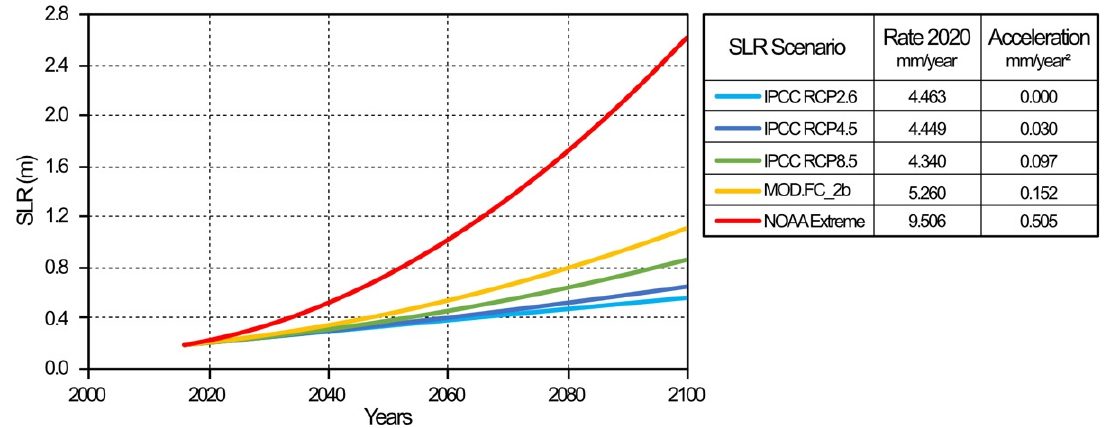
Figure 4. SLR evolution until 2100. SLR rates and acceleration, regarding the Portuguese local datum, for the considered scenarios: IPCC RCP2.6/4.5/8.5, MOD.FC_2b, and NOAA Extreme.